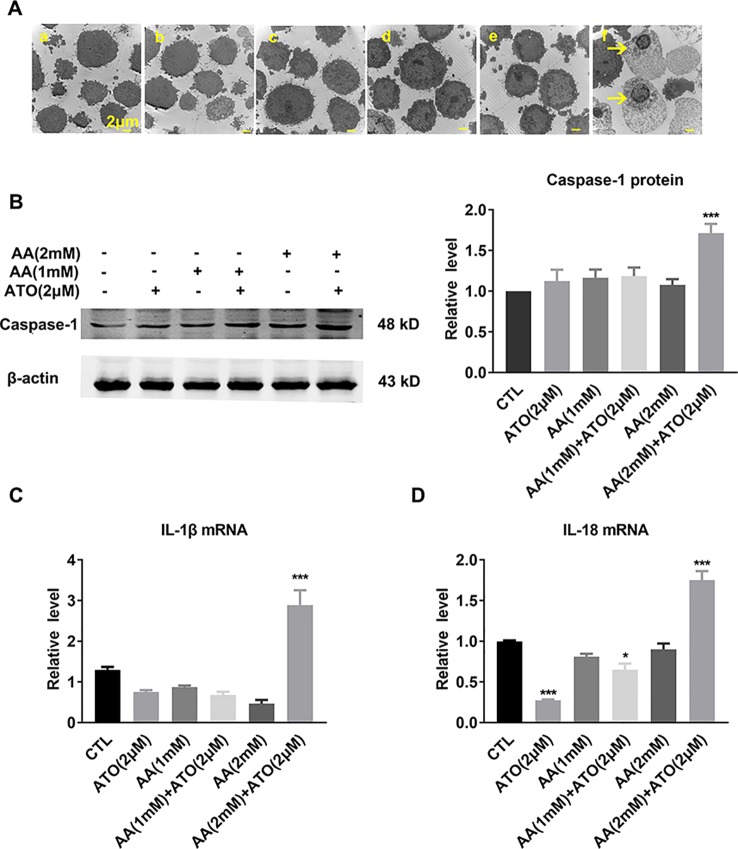
Effects of the co-treatment of AA and ATO on pyroptosis of SW620 cells. (A) Representative images of electron microscopic examination showing the promoting effects of ATO/AA combination treatment on pyroptosis. Yellow arrows indicate the pyroptotic cells with cytoplasmic swelling and nucleus pyknosis. (a) control; (b) ATO (2 μM); (c) AA (1 mM); (d) AA (1 mM) + ATO (2 μM); (e) AA (2 mM); (f) AA (2 mM) + ATO (2 μM). Magnification: ×10000. Scale bar: 2 μm. (B) Synergistic upregulation of caspase-1 protein level by ATO/AA combination treatment, with left panel showing the typical examples of Western blot band images and the right one showing the statistical data expressed as mean ± SEM. ***P < 0.001. (C, D) Synergistic elevation of the mRNA levels pro-inflammatory cytokines IL-1β and IL-18, respectively, by ATO/AA combination treatment in SW620 cells. *P < 0.05, ***P < 0.001. The data are presented as mean ± SEM (n = 3).